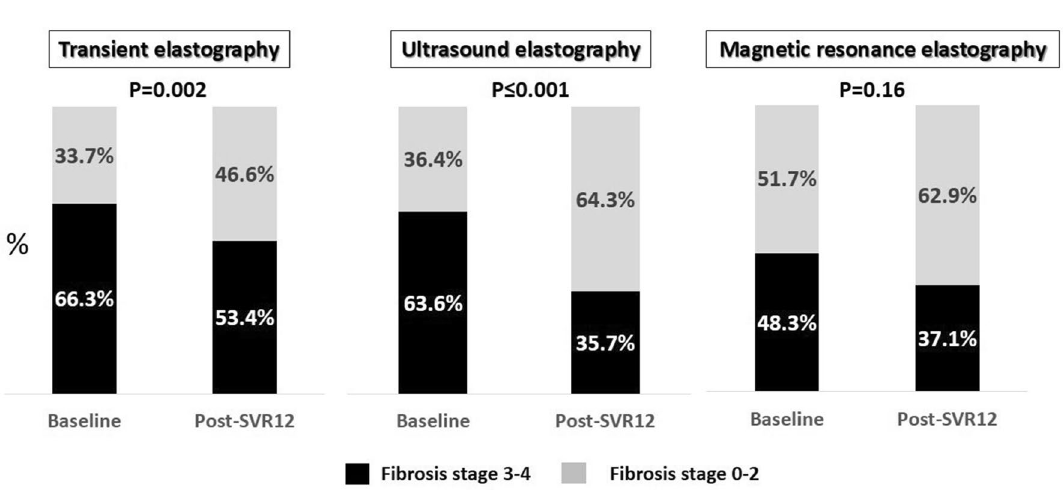
Figure 5. Proportion of advanced liver fibrosis evaluated by TE, SWE and MRE before and one-year after treatment initiation in chronic HCV patients with